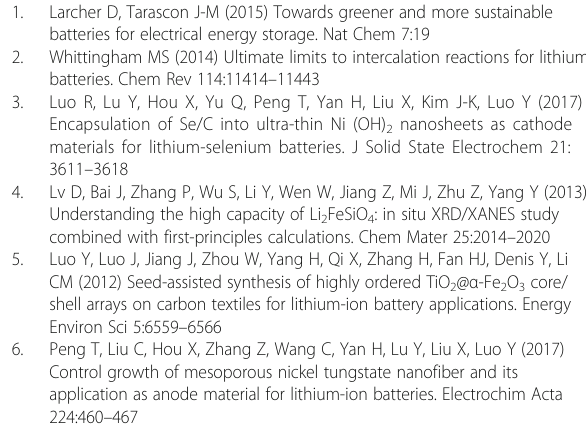
2 . Figure S2. Thermogravimetry of CNT@Li 2 FeSiO 4 and CNT@Li 2 FeSiO 4 @C. Figure S3. The dQ/dV vs. voltage plots of CNT@Li2FeSiO4@C at 0.2 C. Figure S4. The Nyquist plot of CNT@Li2FeSiO4 and CNT@Li2FeSiO4@C electrode and the equivalent circuit for electrodes.